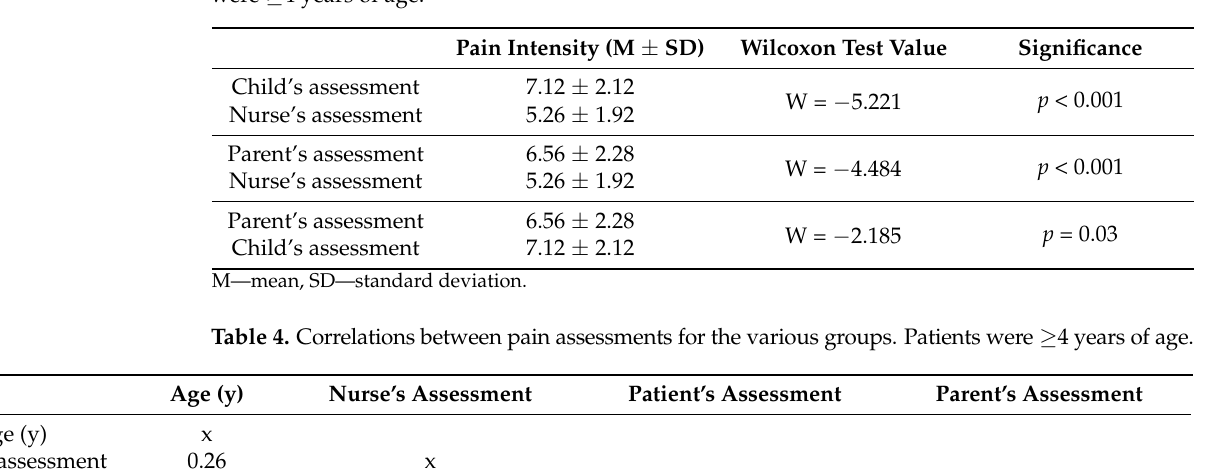
Table 3. Differences in the intensity of pain assessed by nurses, parents and children. Patients were ≥ 4 years of age.